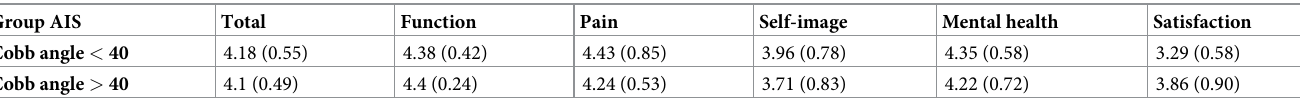
Table 2. SRS-22 outcome in means (SD). Group